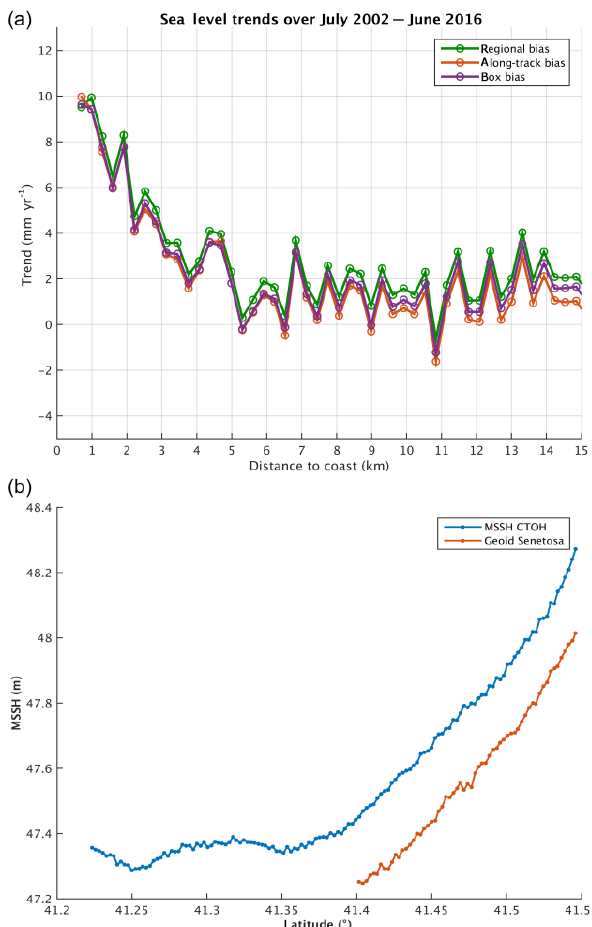
Figure 8. (a) Sea level trends against the distance to the coast for three different inter-mission bias estimates. (b) Geoid and altimetry- based along-track mean sea surface profiles against latitude. MSSH CTOH stands for mean sea surface height determined by